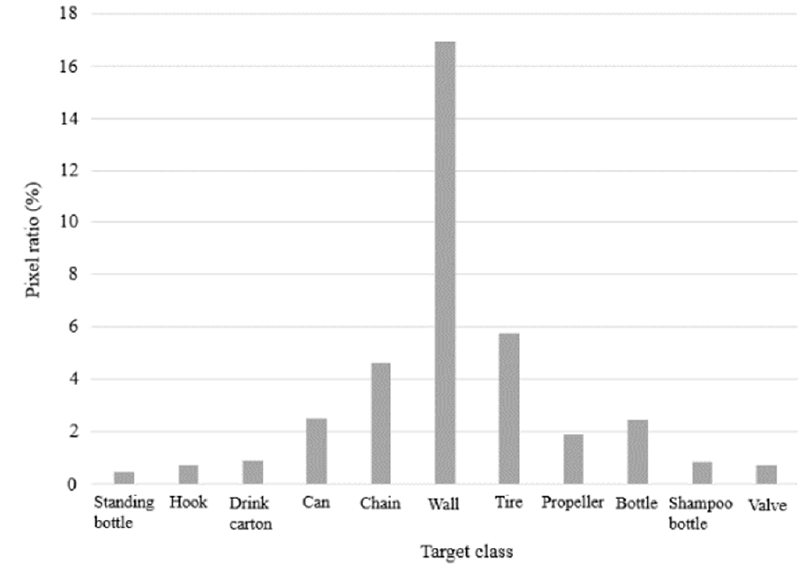
Figure 8. Pixel ratio for each target class.